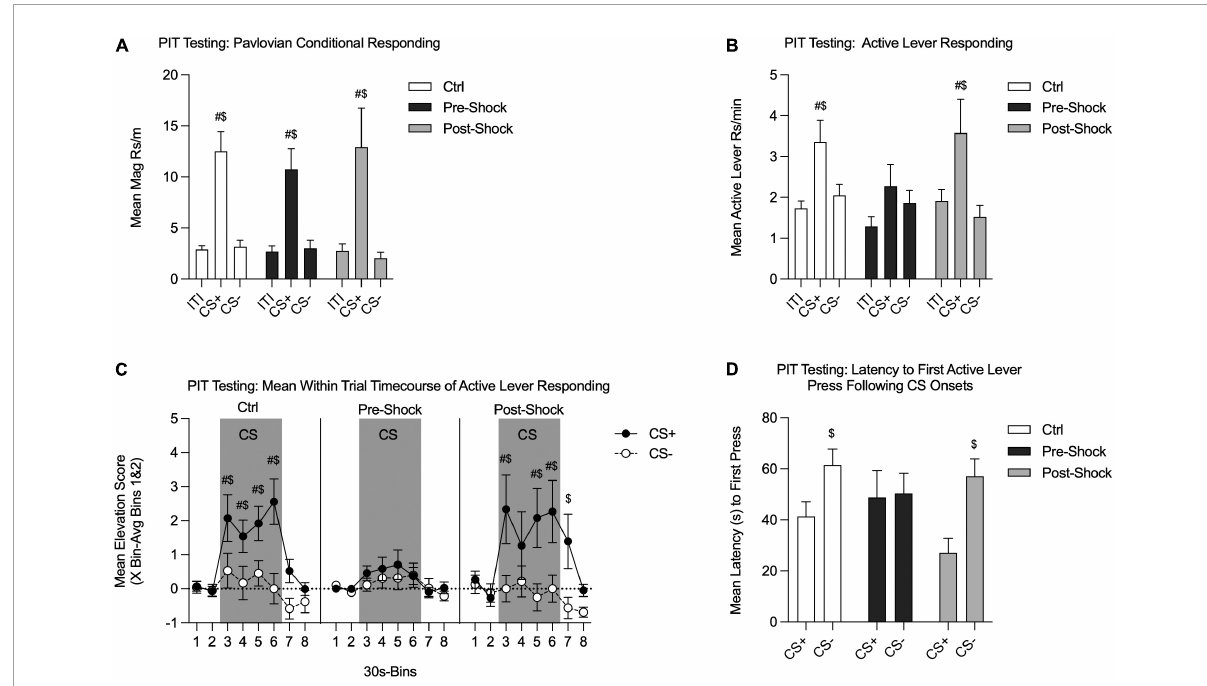
FIGURE4 Single-outcome Pavlovian-to-instrumental transfer tests in Context B in Experiment 1. The Pre-Ctrl and Post-Ctrl groups did not differ and were therefore collapsed. Data are presented as means from Tests 1 and 2. (A) Pavlovian conditional responding during PIT testing. All groups showed robust discrimination between CS+ and CS-. (B) Active lever responding measuring the SO-PIT effect. In the Collapsed Ctrl and Post-Shock groups Active lever responding was significantly greater during CS+ presentations than during the ITI and CS-. However, in the Pre-Shock the rate Active lever responding did not differ between the CS+, ITI, and CS- periods. (C) Mean time course of Active lever from 60 s pre- to 60 s post-CS presentations. Data are presented as an elevation score [responding in the pre-CS period (bins 1 and 2) subtracted from each bin]. In the Collapsed Ctrl and Post-Shock groups, Active lever responding was greater during CS+ vs. CS- presentations throughout the 2 m CS window. In the Post-Shock group this effect carried over into the first 30 s after CS offset. In contrast, the Pre-Shock group did not show any significant increase Active lever responding during CS+ vs. CS- presentations at any point within the CS window. (D) Active lever response latency during PIT testing. In the Collapsed Ctrl and the Post-Shock groups, the latency between CS+ onset and the first Active lever response